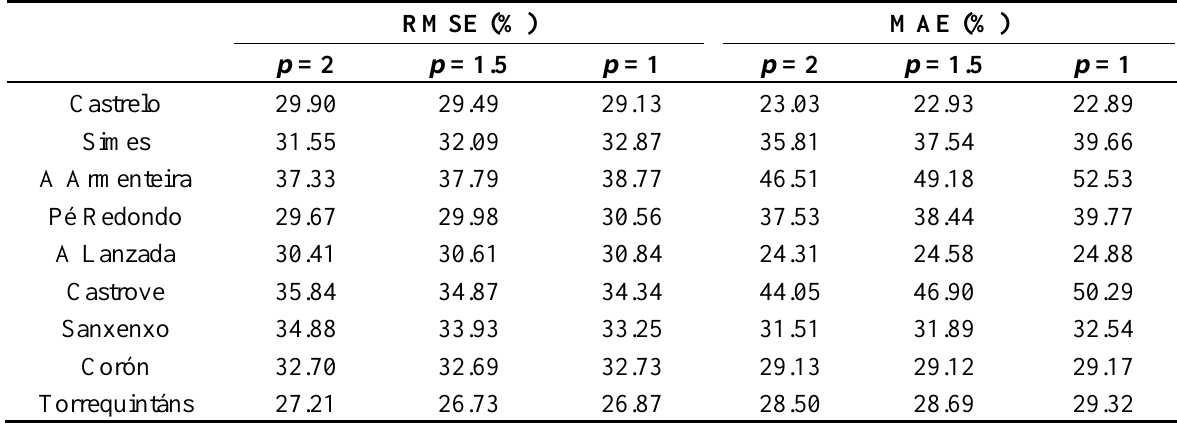
Table 5. RMSE and MAE obtained with the IDW